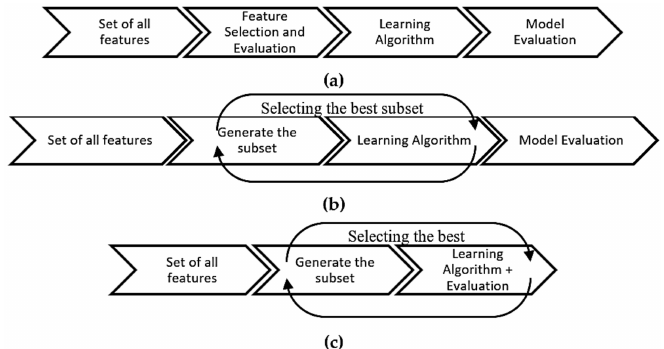
Figure 1. ( a )Filterfeatureselectionmethod, ( b )wrapperfeatureselectionmethodand( c )hybrid / embedded feature selection